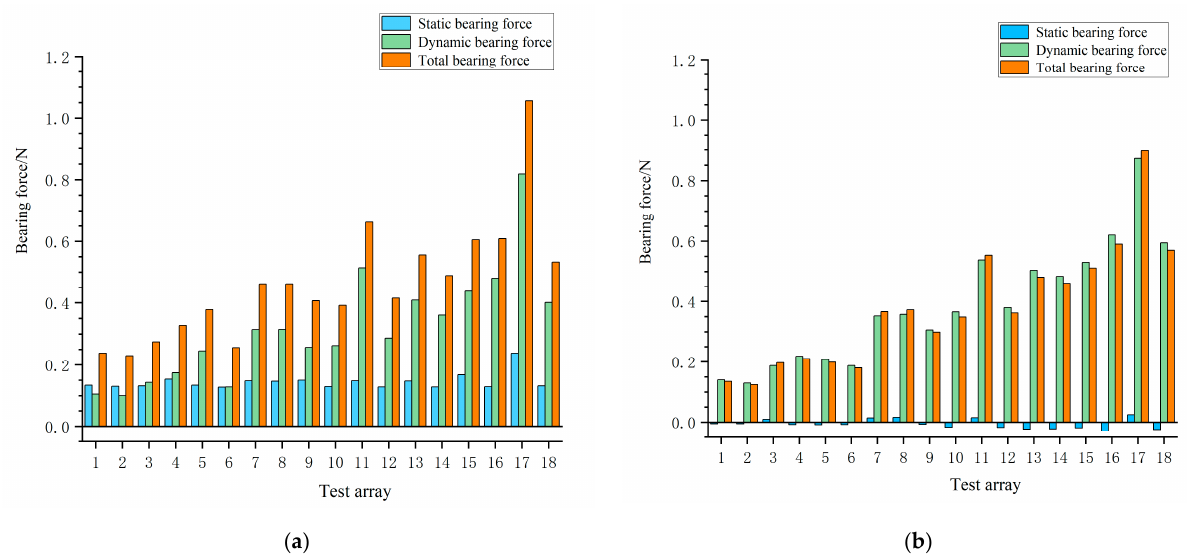
Figure 12. Histogram of bearing force of 18 groups of orthogonal tests with and without cavitation effect. ( a ) With cavitation effect; ( b ) Without cavitation effect. effect. ( a ) With cavitation effect; ( b ) Without cavitation